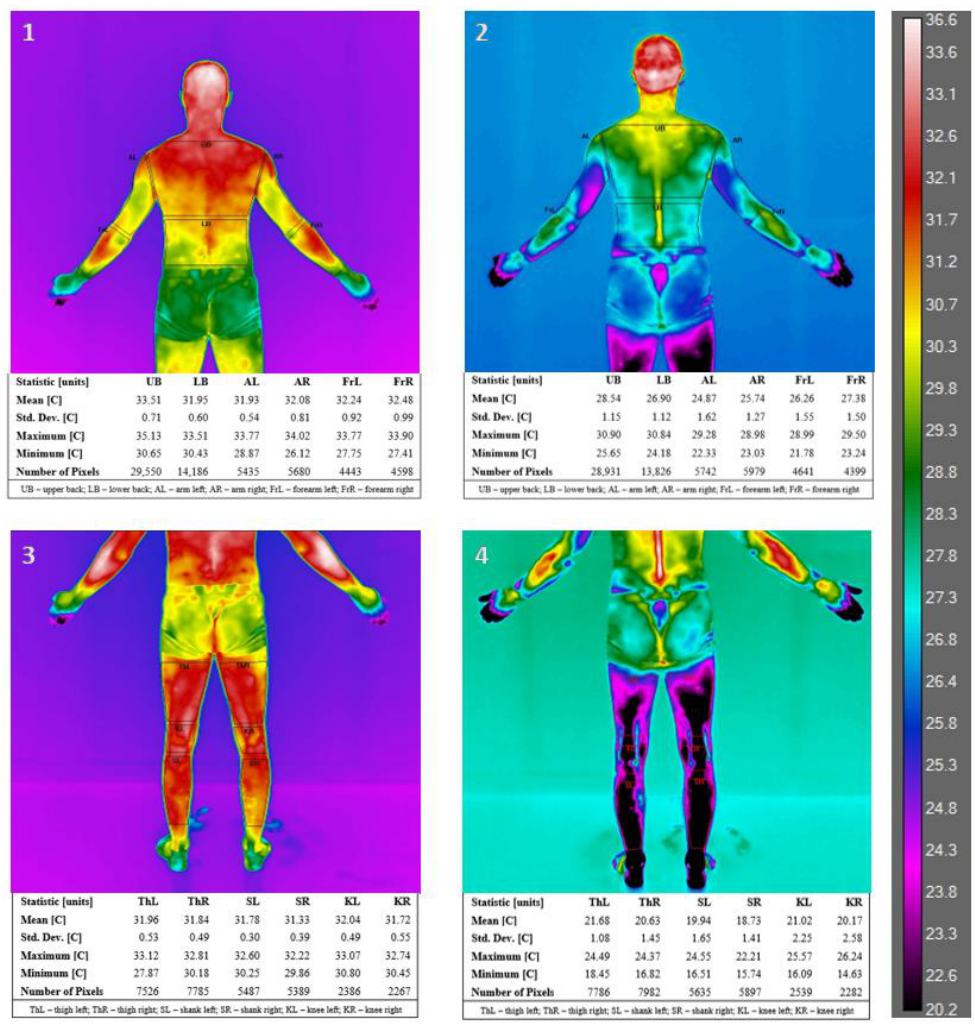
Figure 2. Sample thermographic photos before (1 and 3) and after (2 and 4) partial body cryostimu- lation for the back view. Legend: Ch — chest; Ab-abdominal; AL — left arm; AR — right arm; FrL — left forearm; FrR — right forearm; ThL — left thigh; ThR — right thigh; SL — left shank; SR — right shank; KL — left knee; KR-right knee.